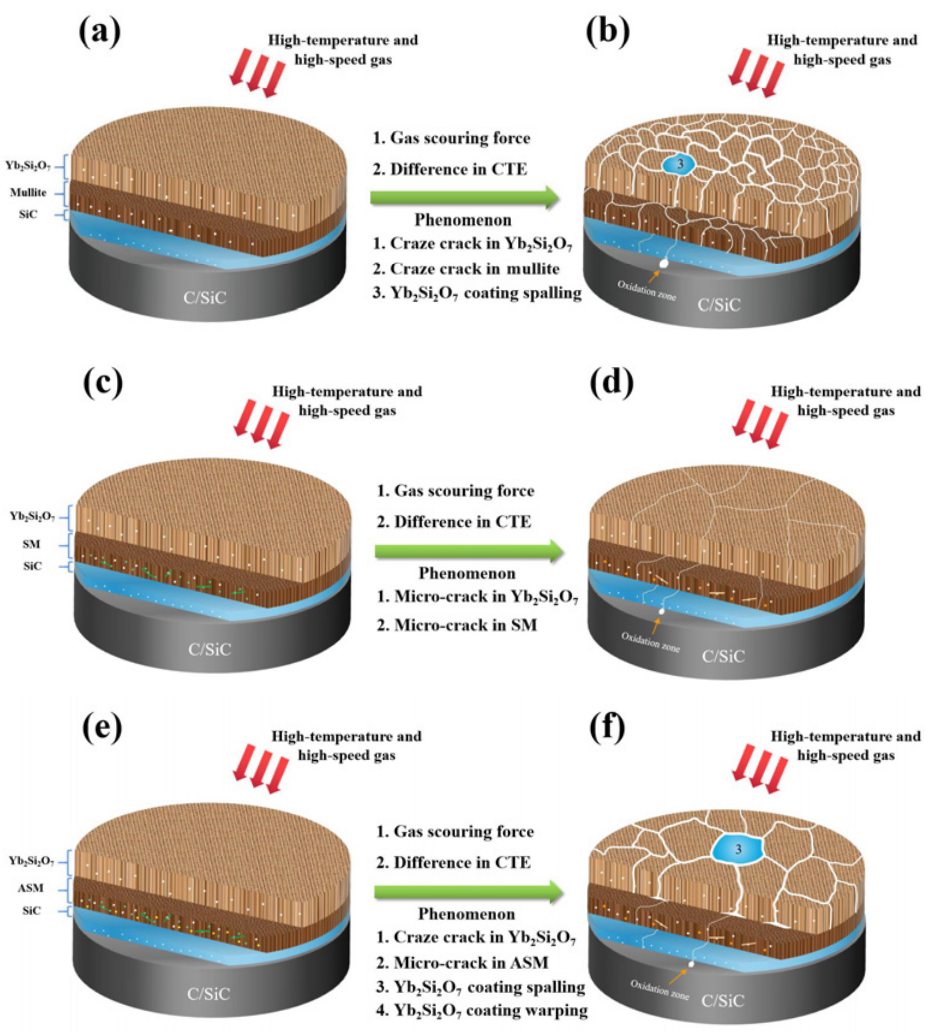
Fig. 15 Oxidation resistance and failure mechanism of tri-layer Yb 2 Si 2 O 7 /mullite/SiC, Yb 2 Si 2 O 7 /SM/SiC, and Yb 2 Si 2 O 7 / ASM/SiC coatings-coated C f /SiC samples at 1673 K in the burner rig